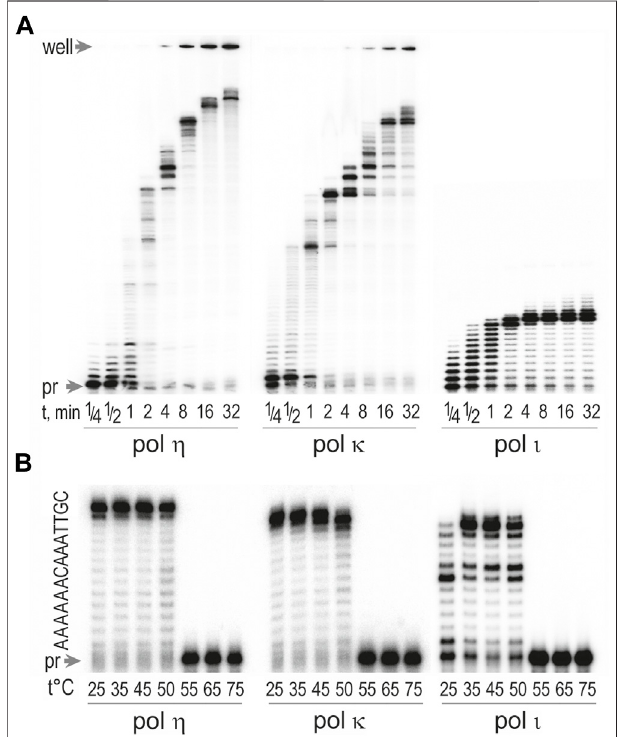
FIGURE 4 | Thermostability and processivity of Thermomyces lanuginosus pols η , κ , and ι . Concentrations of enzymes were 0.17 pM for pol η , 0.32 pM for pol κ , and 0.15 pM for pol ι . (A) Processivity of pols η , κ , and ι were assayed in reactions containing 100 μ M dNTPs and 4 mM MnCl 2 for pol ι or MgCl 2 for pol η and pol κ . Extension of 32 P labeled primer 5 ′ TATTTA TCCCAATCCAAATAAGAAACGA-3 ′ hybridized to the circular single- stranded 7.2 kb M13mp18 bacteriophage was at 37 ° C for various times ranging from 0.25 to 32 min. Reactions containing 100 μ M dNTPs and 4 mM MnCl 2 for reactions with pol ι and MgCl 2 for reactions with pol η and pol κ . ( B ) Thermostability was assayed by primer extension reactions using DNA template generated by annealing of a 32 P-labeled primer 5 ′ -TATTTATCCCAA TCCAAATAAGAAACGA-3 ′ with an undamaged DNA template 5 ′ -CGTTAA ACAAAAAATCGTTTCTTATTTGGATTGGGATAAATA-3 ’ . Reactions were carried out for 10 min at various temperatures ranging from 25 to 75 ° C and contained 100 μ M dNTPs and 4 mM Mn 2+ to activate pol ι or Mg 2+ to activate pol η and pol κ